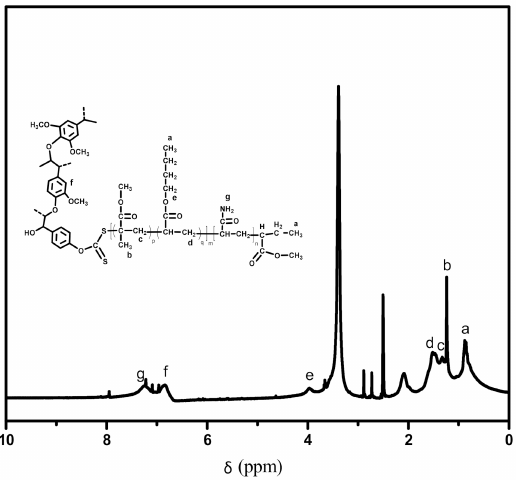
Figure 5. 1 H NMR spectrum of lignin-g-PAM-b-(MMA- co -BA).